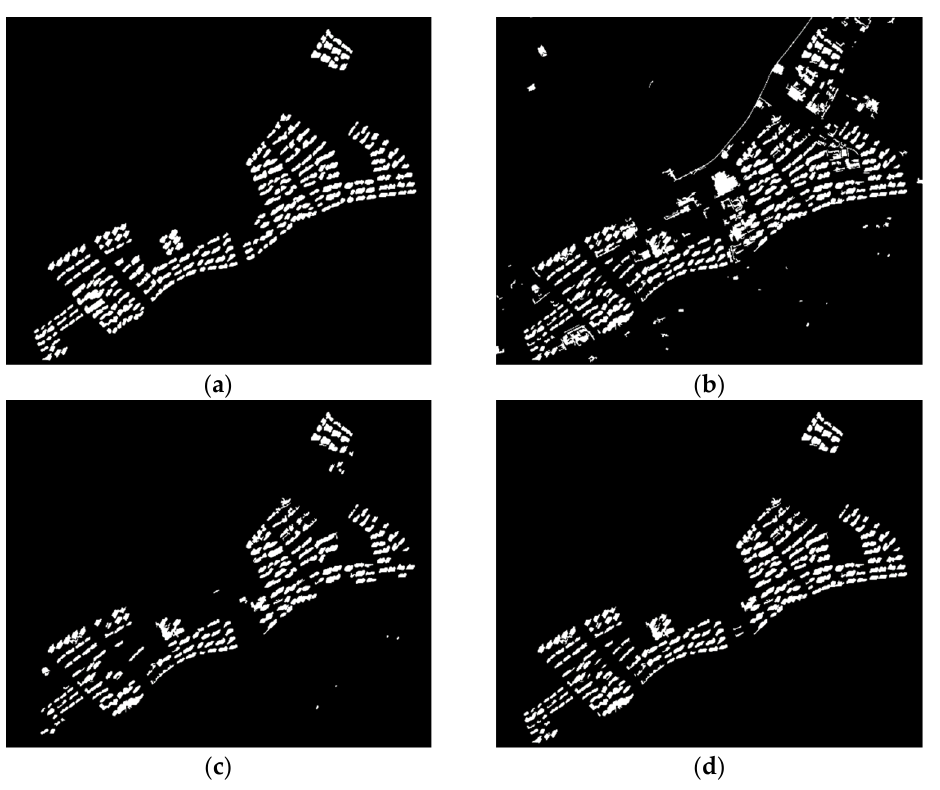
Figure 10. HRB detection results from Site 2. ( a ) Reference data; ( b ) HRB detection result by MBI; ( c ) HRB detection result by MBI with shadow intensity [42]; and ( d ) HRB detection result by MBI with digital maps. Table 5. Accuracy of HRB detection for Site 2.